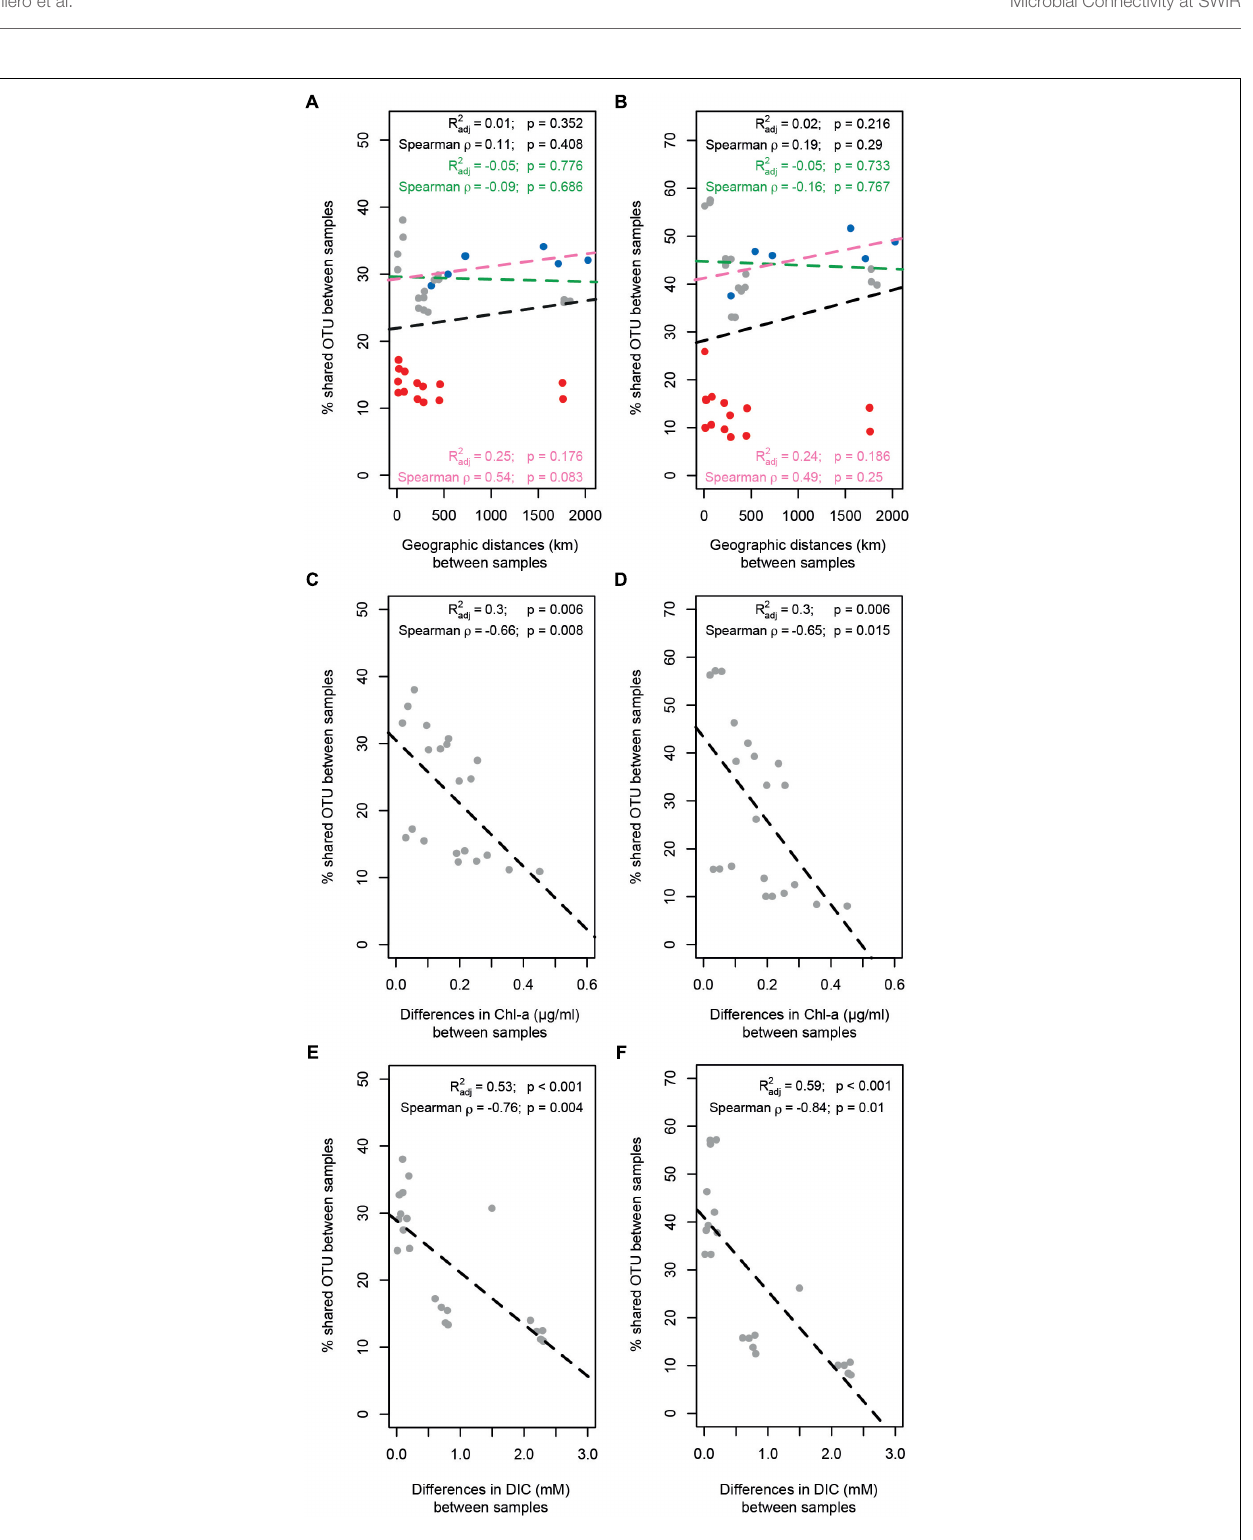
Frontiers in Microbiology |